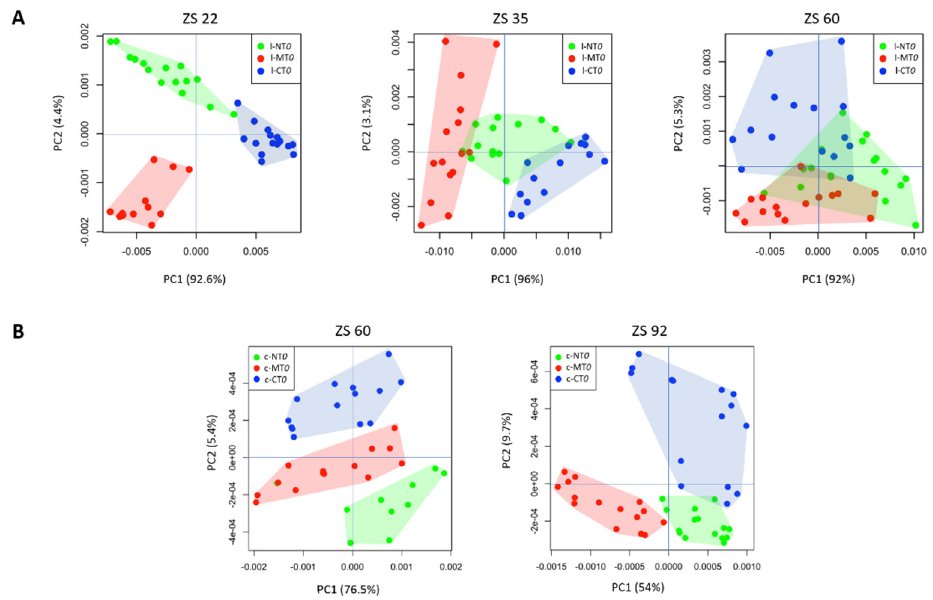
Figure 4. Principal component analysis (PCA) score plots of the spectral data of durum wheat leaves